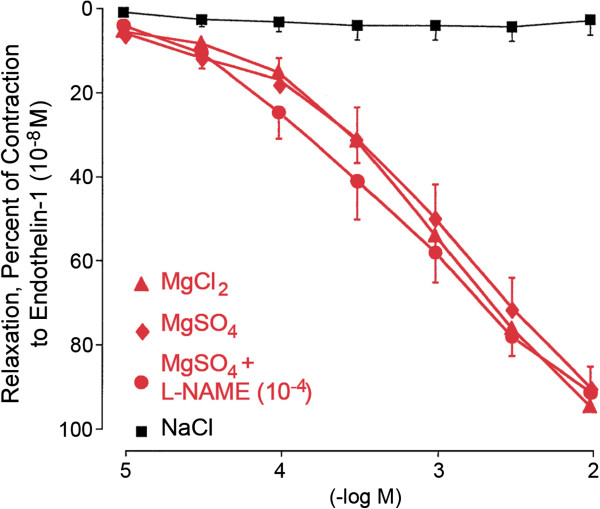
Similar relaxing effect of increasing MgSO4 and MgCl2 concentrations added to ET-1 precontracted ciliary arteries. (Modified from [303], with permission).